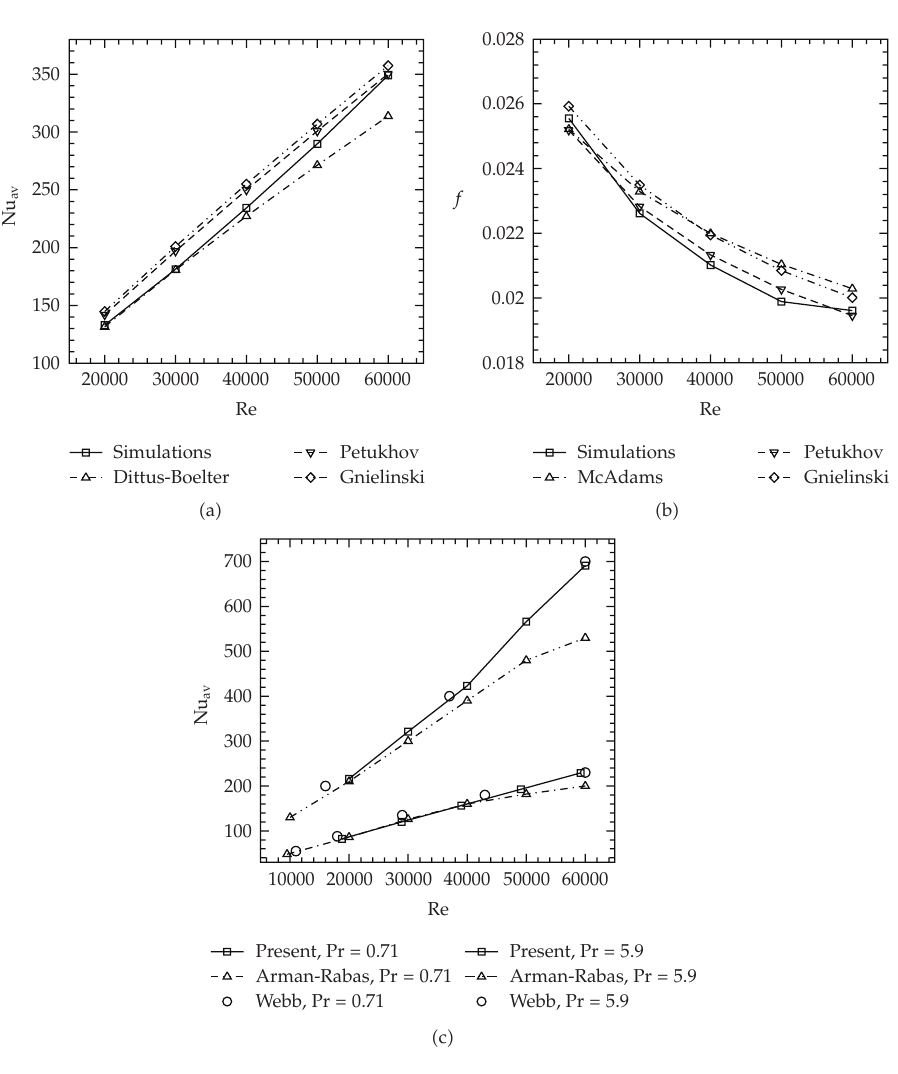
Figure 3: Validation of results: (cid:6) a (cid:7) average Nusselt number, smooth channel, (cid:6) b (cid:7) friction factor, smooth channel, and (cid:6) c (cid:7) average Nusselt number, ribbed channel (cid:6) rectangular ribs, w/e (cid:8) 0 . 5, e/d (cid:8) 0 . 02, and p/e (cid:8) 20 (cid:7)